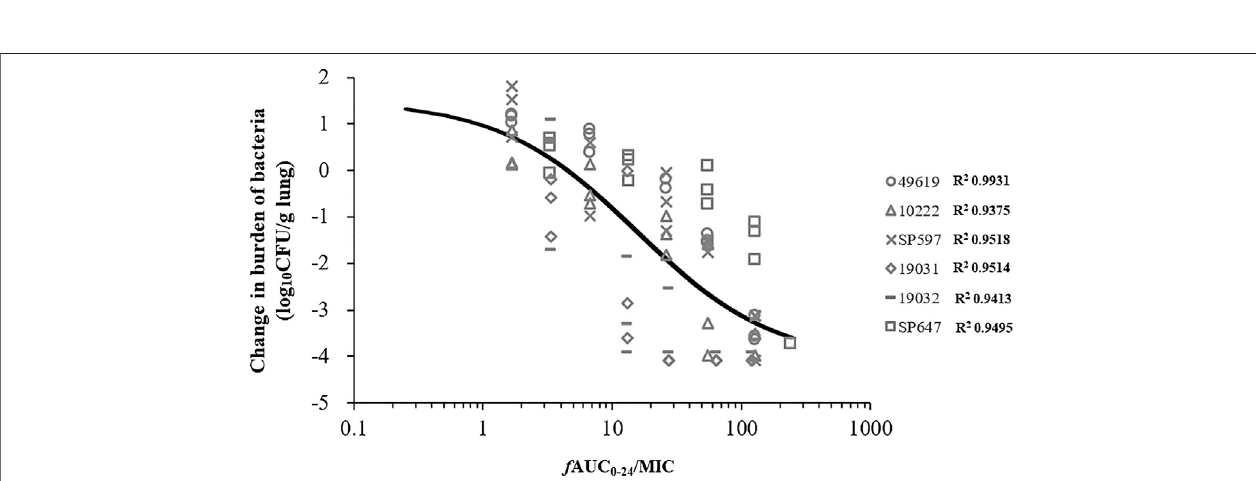
Frontiers in Pharmacology |